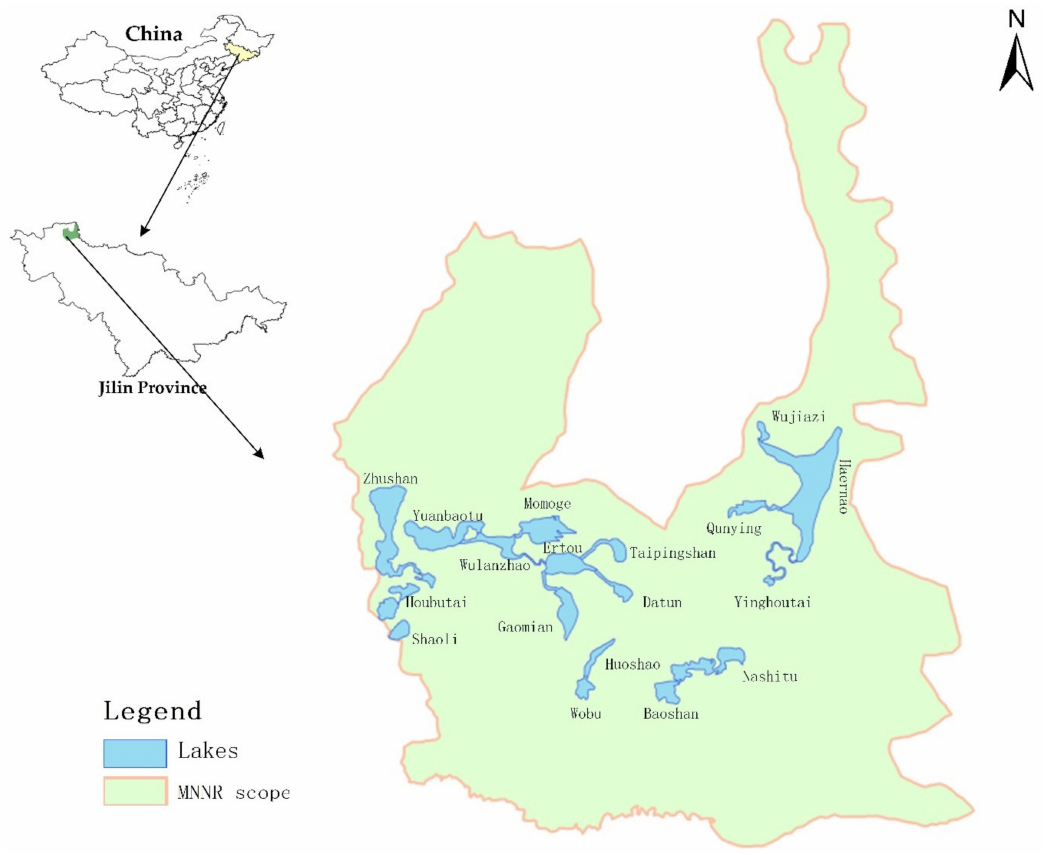
Figure 1. The geographical locations of the study area (MNNR = Momoge National Nature